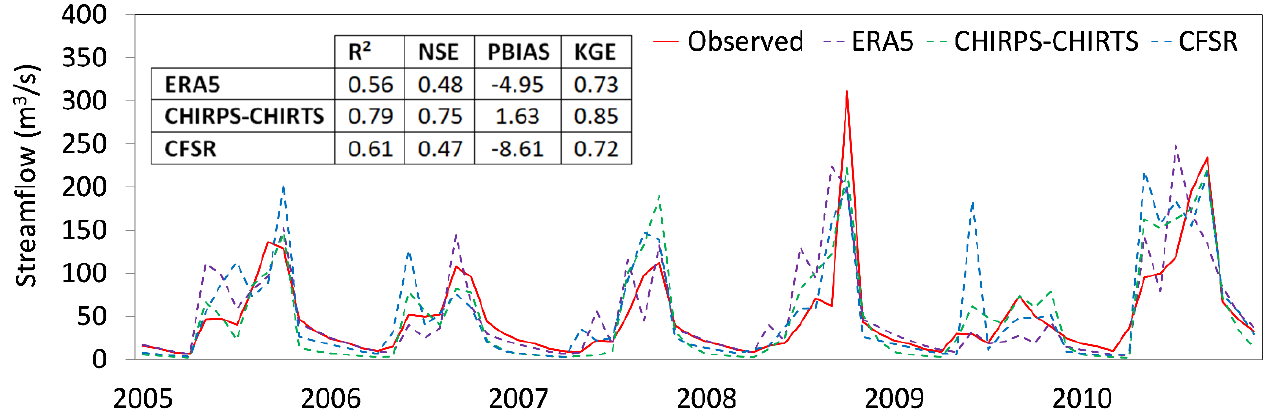
Figure 7. Model performance comparison between simulated and observed monthly streamflows after calibration using GLoFAS discharge data.